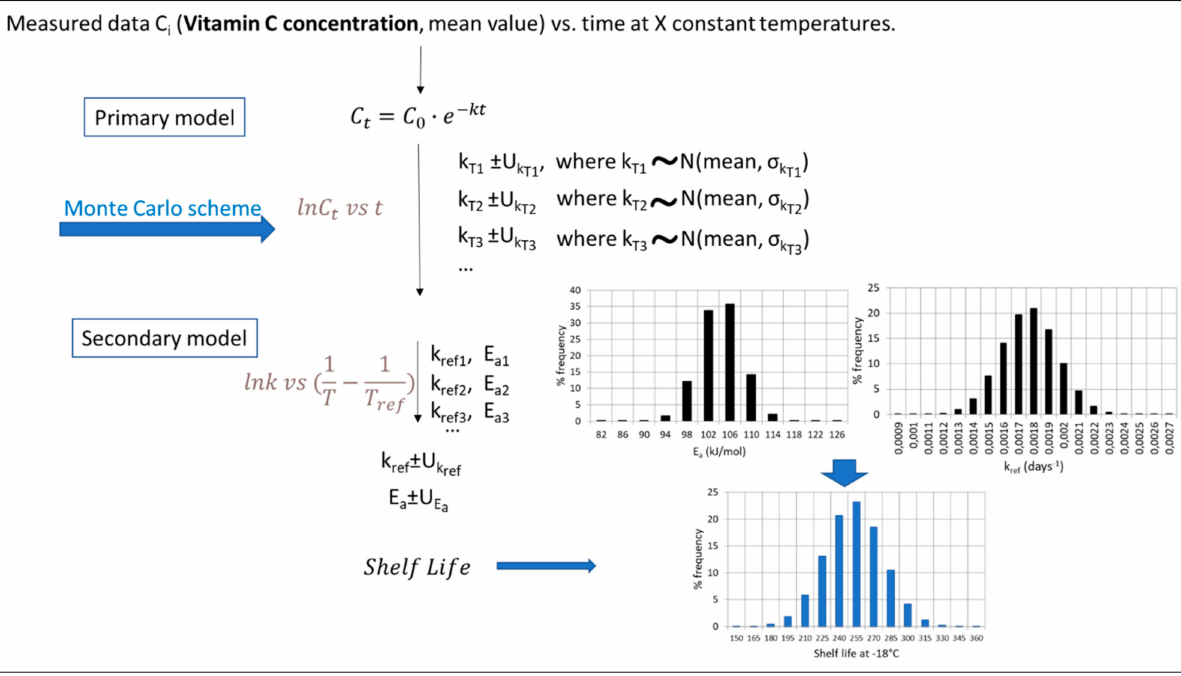
Figure 6. Indicative workflow of a stochastic approach (based on a two-step analysis) using an example of the Vitamin C loss during frozen storage for vegetables, providing a distribution curve for the prediction of the shelf